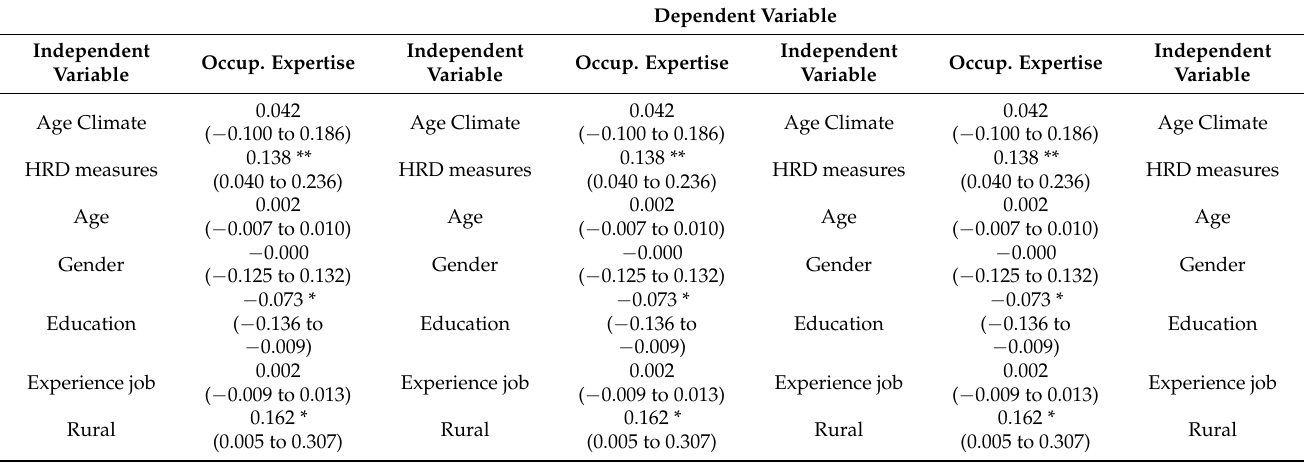
Table 2. Path coefficients (B) with bootstrapped 95% confidence intervals (1000 bootstrap samples) in brackets. (Source: